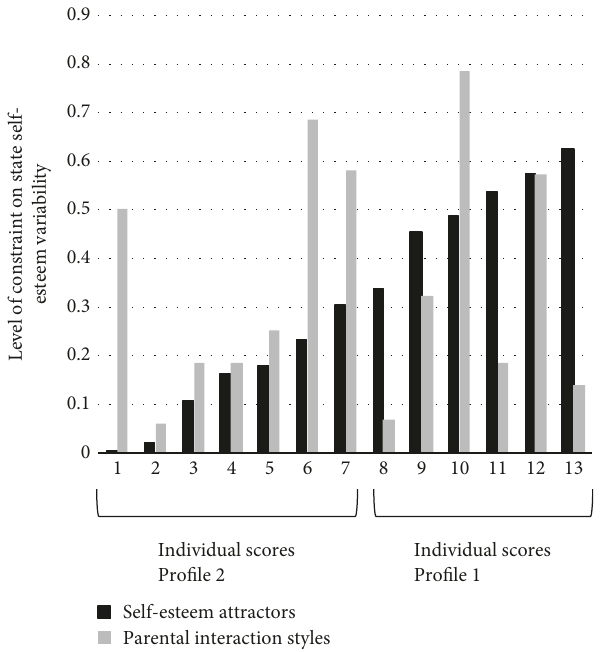
Figure 9: Individual levels of temporal correspondence between SSE and self-esteem attractors with SSE and parental interaction